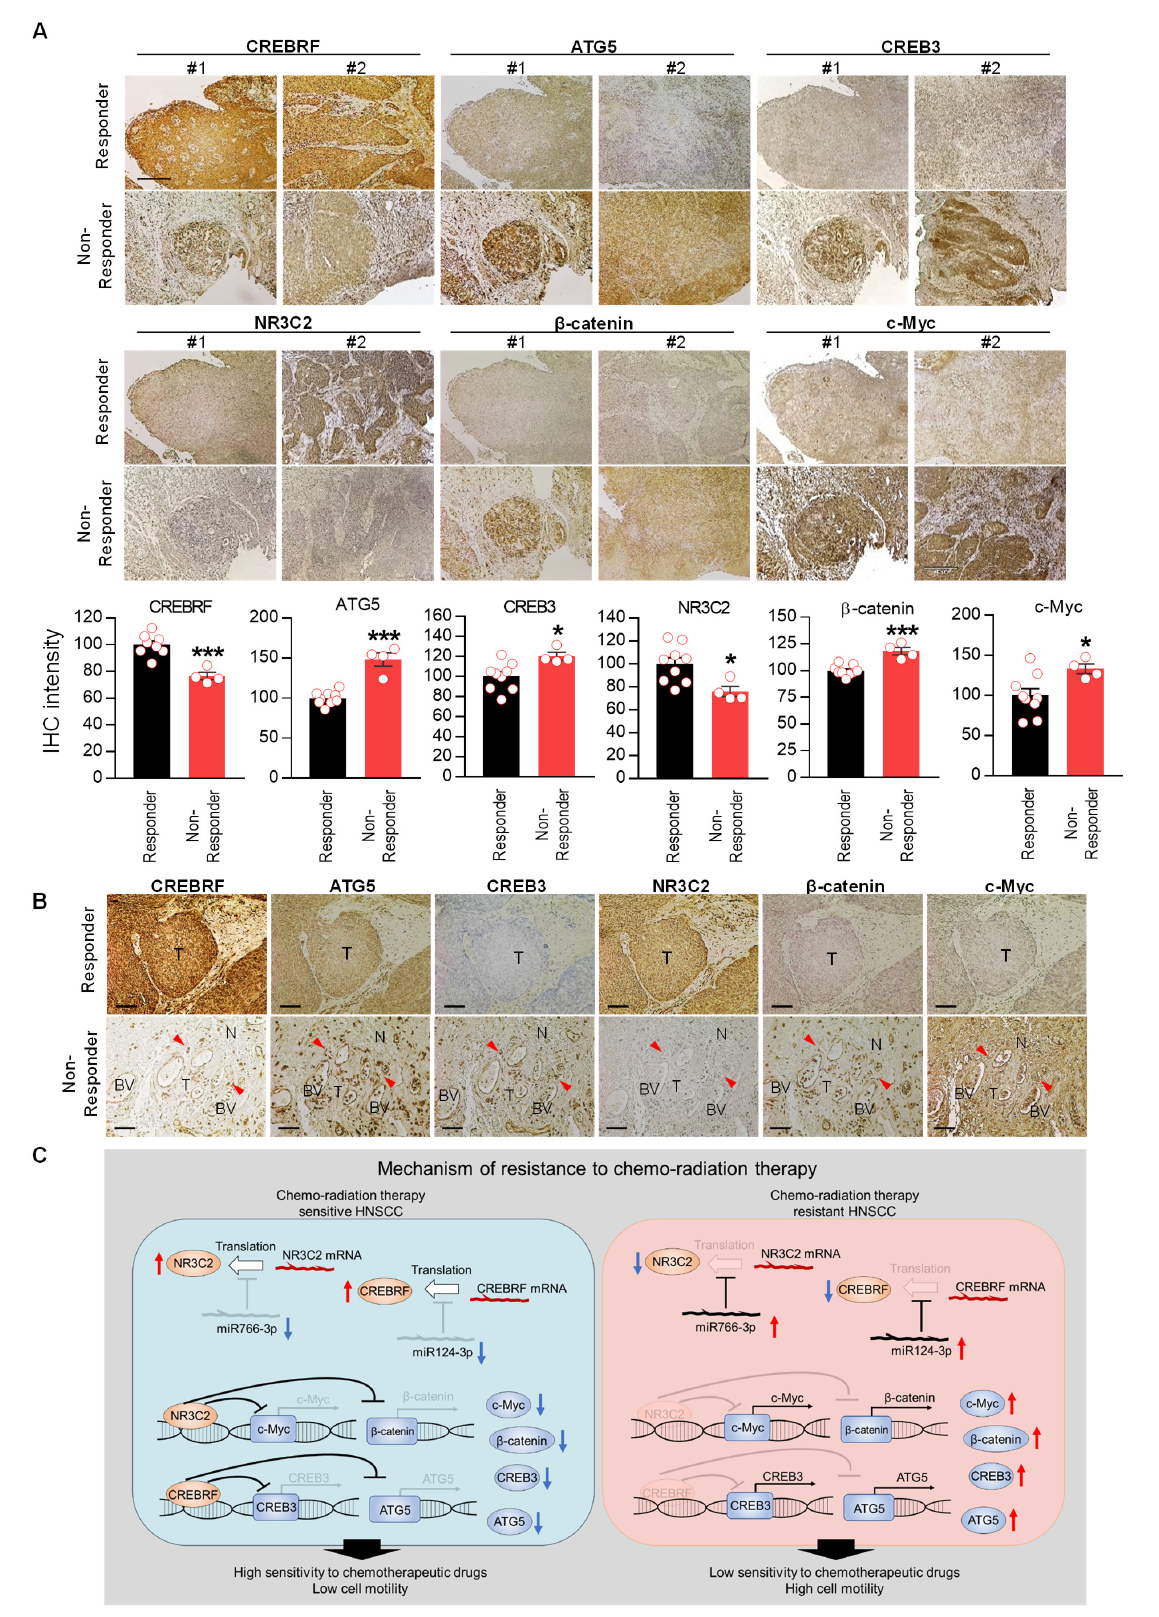
Figure 9. Downregulation of CREBRF and NR3C2 increase poor prognosis in HNSCC. ( A ) His- tological analysis of miR124-3p and miR766-3p target gene expression